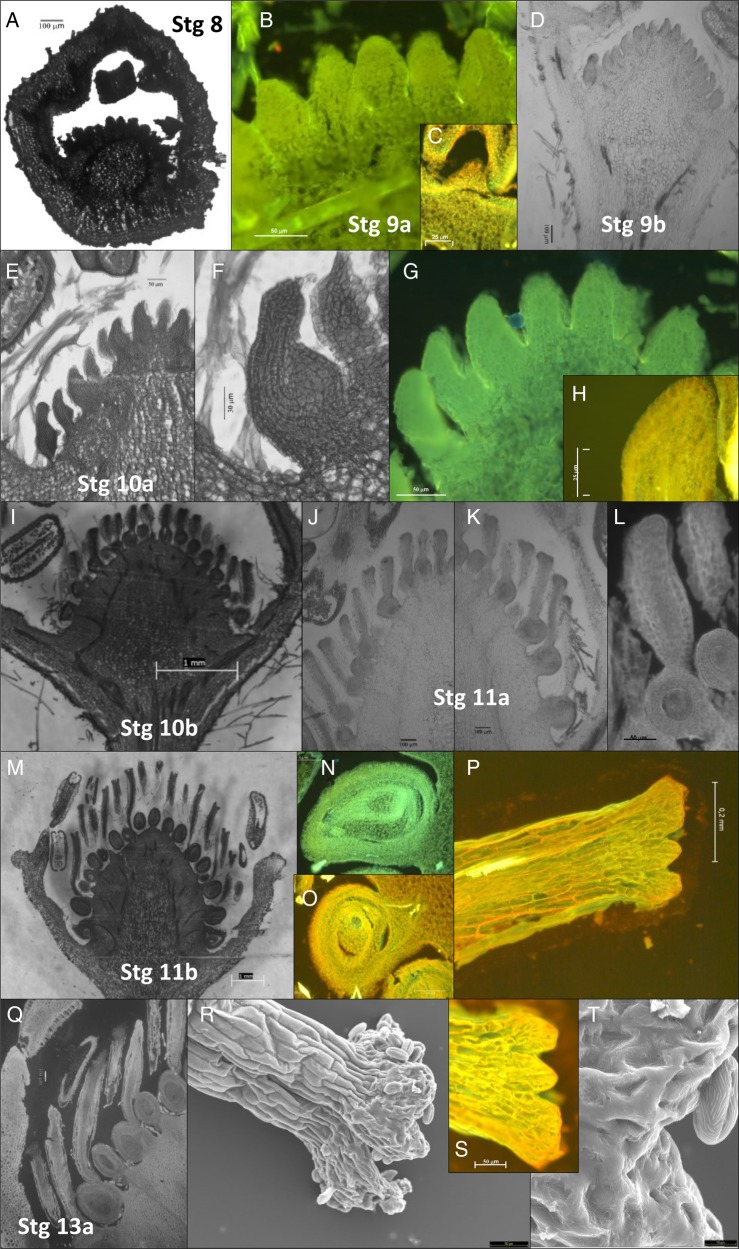
Micrographs of pistil development of F.× ananassa flower buds at different developmental stages (Stg): stage 8 (A), stage 9a (B and C), stage 9b (D), stage 10a (E–H), stage 10b (I), stage 11a (J–L), stage 11b (M–P) and stage 13a (Q–T). Histological sections embedded in paraffin were stained with PAS or toluidine blue (shown in black and white) for structural examination. Samples embedded in historesin were stained with auramine O (green coloured) and acridine orange (yellow coloured) for a morpho-functional approach. Three-dimensional images of stigmas were acquired by scanning electron microscopy.